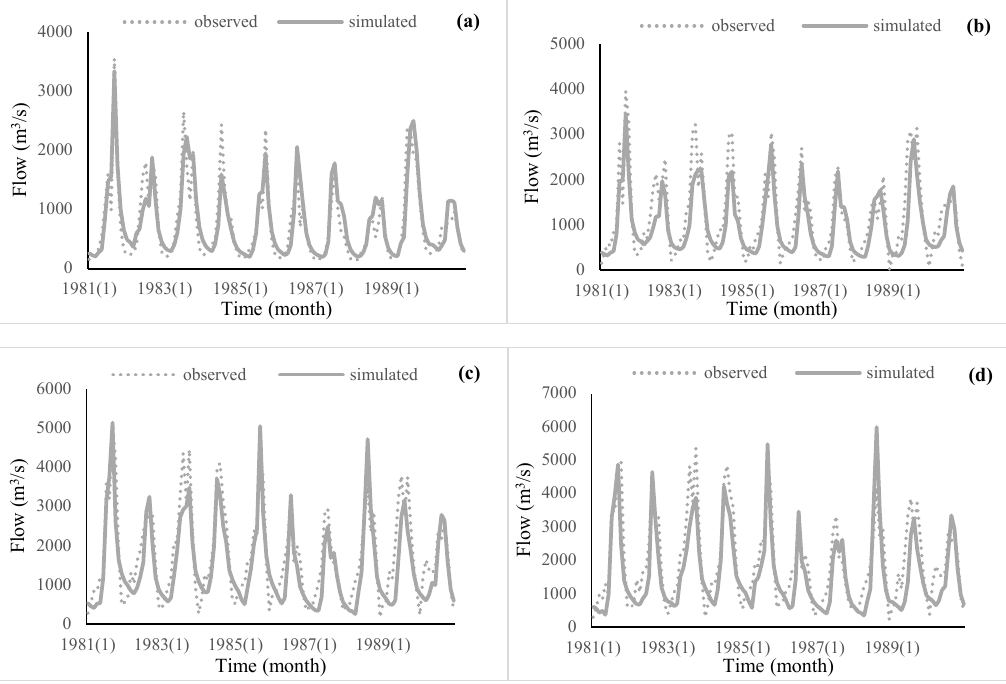
Figure 5. Monthly flow observation and simulation values of Tangnaihai ( a ), Toudaoguai ( b ), Sanmenxia ( c ) and Lijin ( d ) during validation period (1981–1990). Table 4. Determination coefficient ( R 2 ) , Nash–Sutcliffe coefficient ( NS ) , relative error ( RE ) values for calibration and vali ‐ dation period.